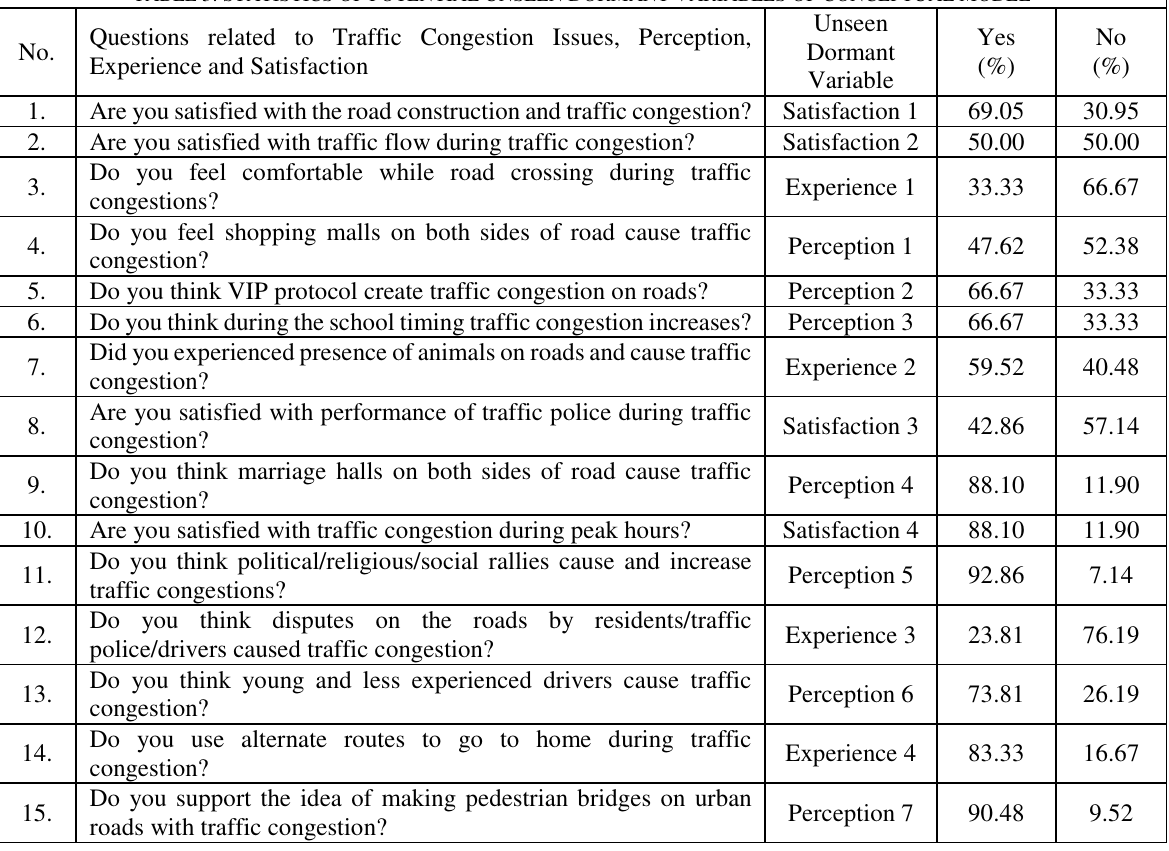
Table 3 comprehends the statistics of the potential unseen dormant variables of the conceptual model shown earlier. Each unseen dormant variable was evaluated by minimum four pointers where each pointer signifies an entry of questionnaire as responded by car drivers and owners on five point scale. An especial attention was given to perception with more than four pointers due to its significance and an inbuilt duality. Because, perception lead to satisfaction and satisfaction makes alterations and modifications in the thought process and change the perception in